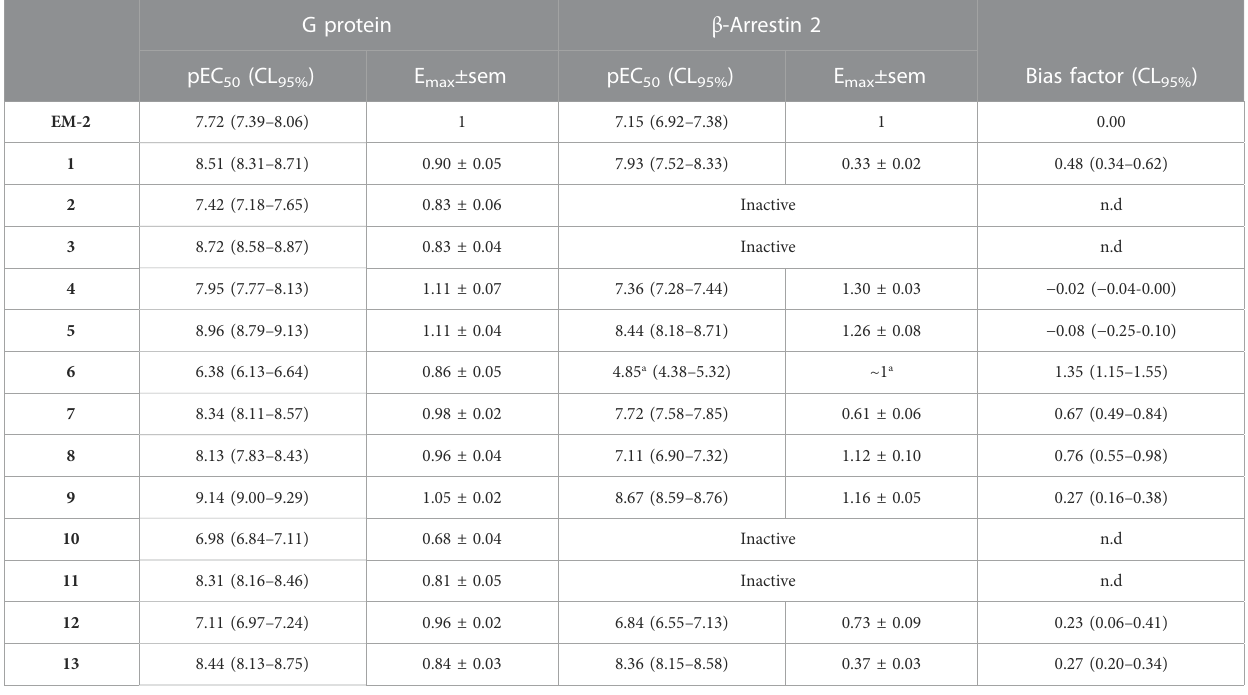
TABLE 4 Pharmacological parameters of EM-2 and its derivatives on mu-G protein and mu- β -arrestin 2 interaction assays. G